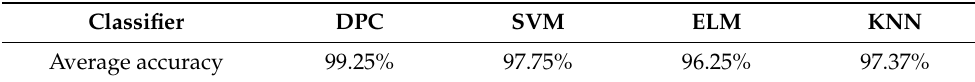
Table 5. Average accuracy of different classifiers.